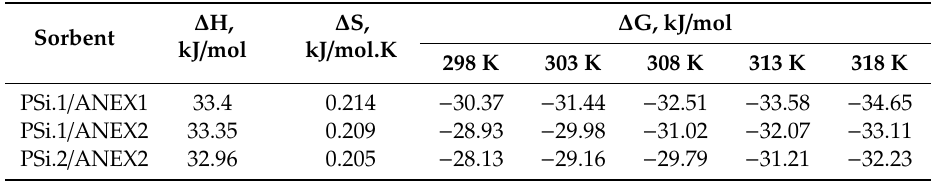
Table 4. Thermodynamic parameters for the sorption of Cr(VI) oxyanions onto the porous silica/ANEX composite sorbents .